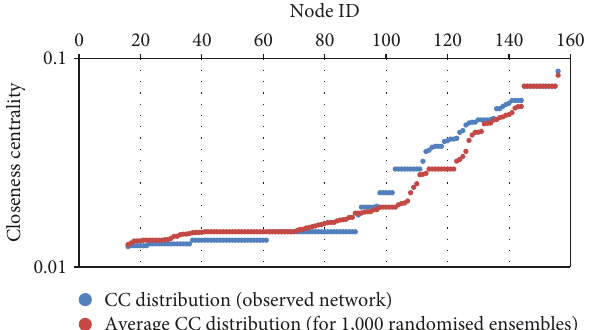
Figure 6: Closeness centrality distribution of the observed SCN (ref #: 16 — Electromedical and Electrotherapeutic Apparatus) against the average closeness centrality distribution obtained from 1000 randomised ensembles.